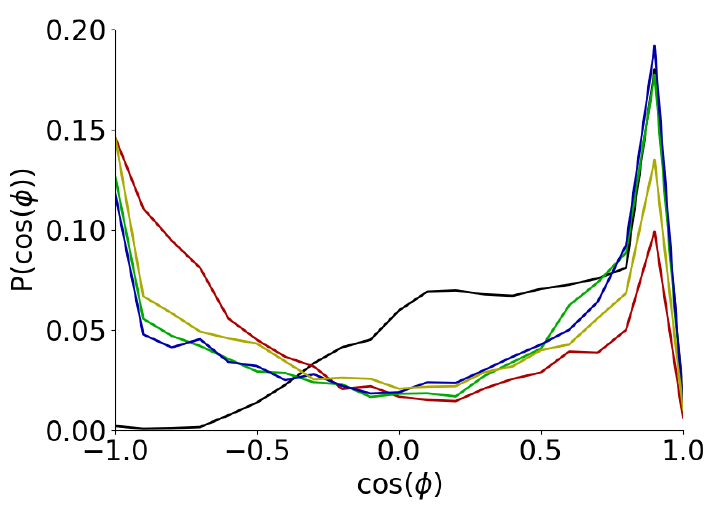
Figure 4. Probability distribution of angle between phenylalanine side chains for Au111 (black), Au100 (red), Ag111 (green), Ag100 (blue) surfaces, and bulk solution (yellow).